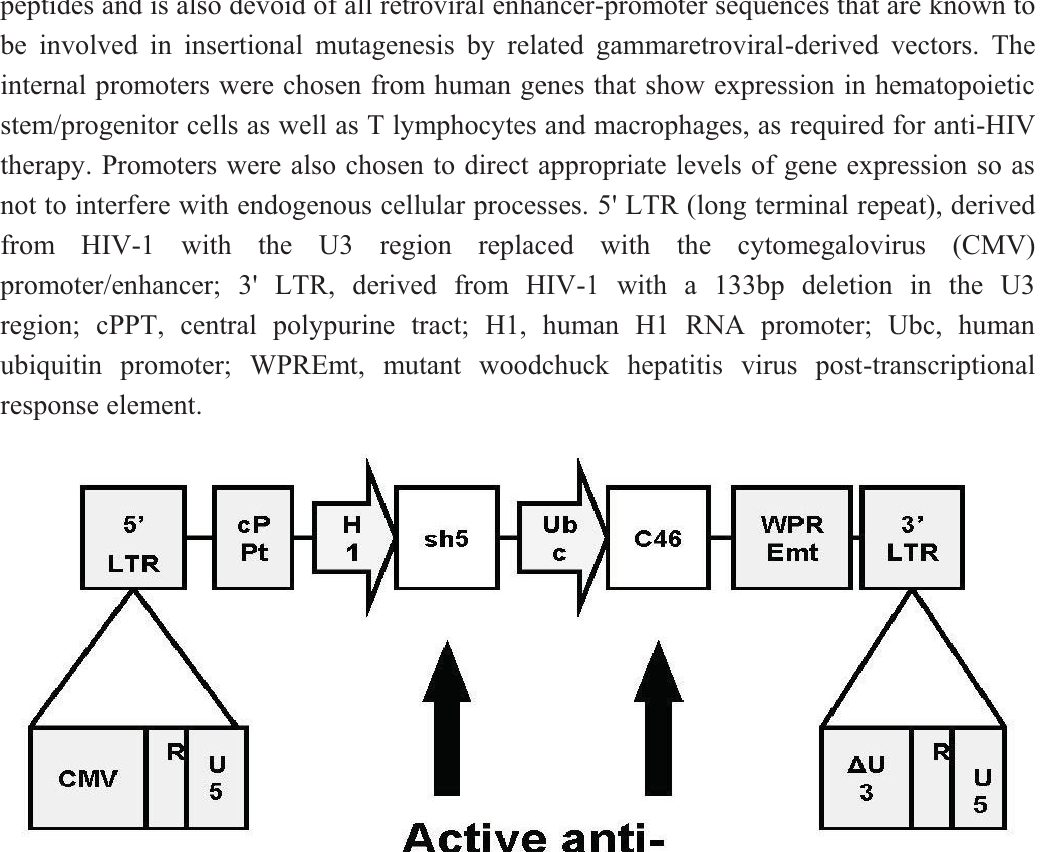
Figure 1. Lentiviral construct LVsh5/C46. LVsh5/C46 is a self-inactivating